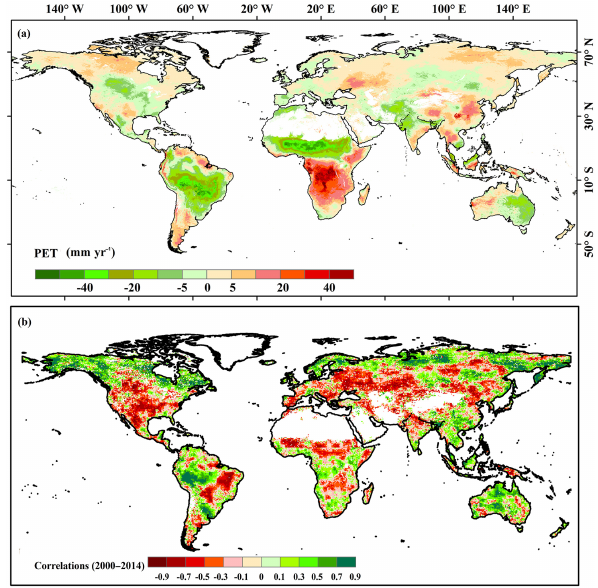
Figure 4. (a) Spatial pattern of PET trend. (b) Partial correlations between NPP and